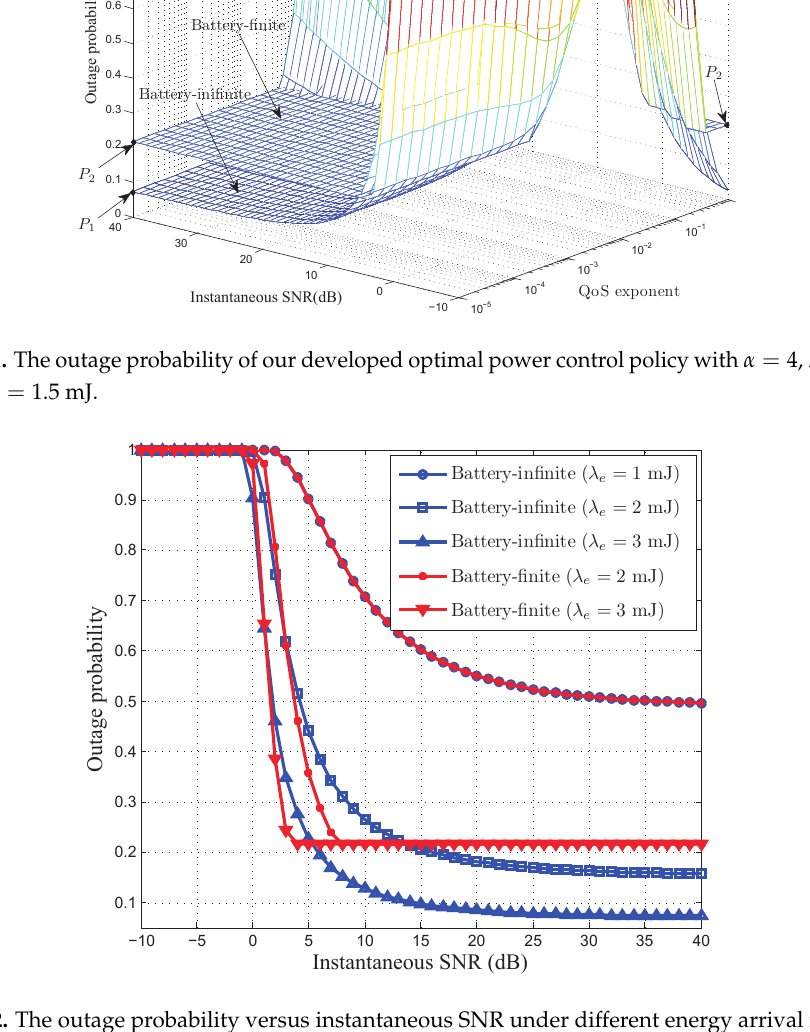
Figure 12. The outage probability versus instantaneous SNR under different energy arrival rates with θ = 10 − 4